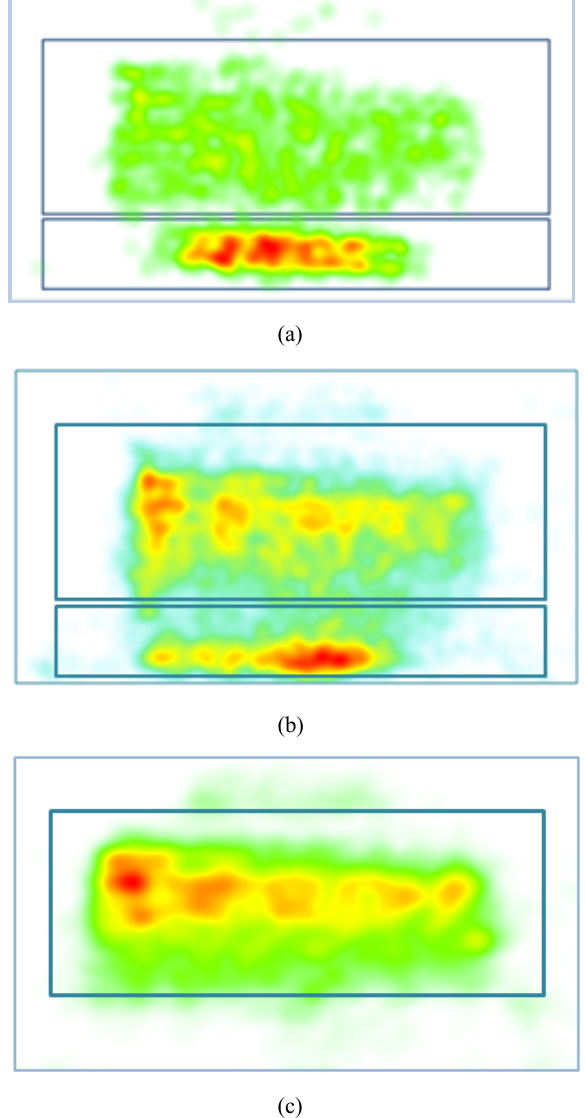
Figure 3. Heat maps for (a) MS, (b) ES, and (c) NS groups. It is evident that MS and ES groups paid attention to the subtitle area apart from attending to the content area (more red/dark shades). Red/dark shade indicates high density of fixations and green/light shade indicates low density. The two analytical sections are the Content AOI (upper box) and Subtitle AOI (lower box, when pre-